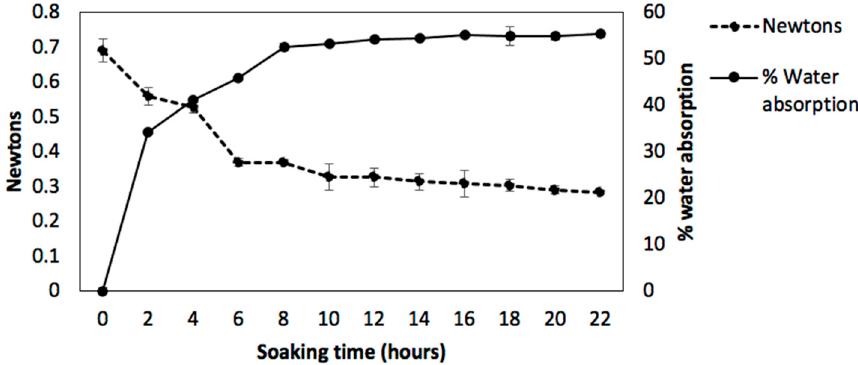
Figure 1. Water absorption and texture during the soaking time of raw chickpea.